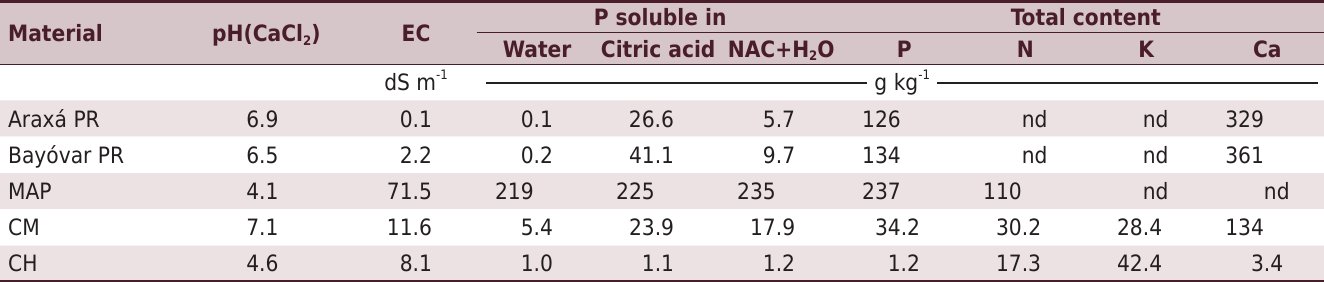
Table 1. Chemical properties of phosphate rocks, monoammonium phosphate, and organic waste samples used in composting Material